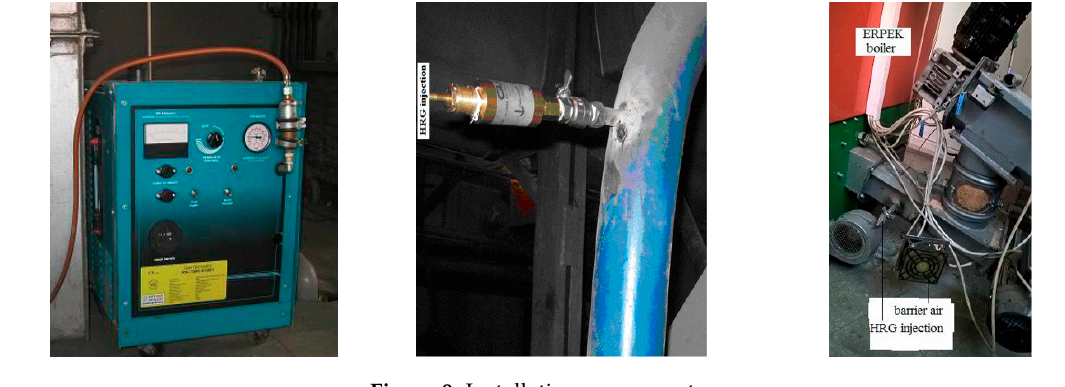
Figure 9. Installation components.